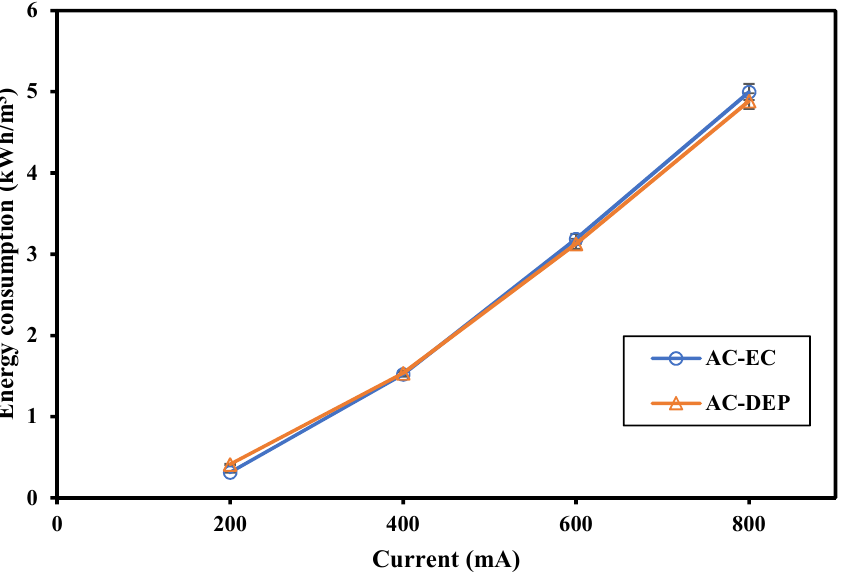
Figure 13. AC-EC and AC-DEP energy consumption using 30 min of operational time and 0.5 cm electrodes spacing on four different currents: 200, 400, 600 and 800 mA.